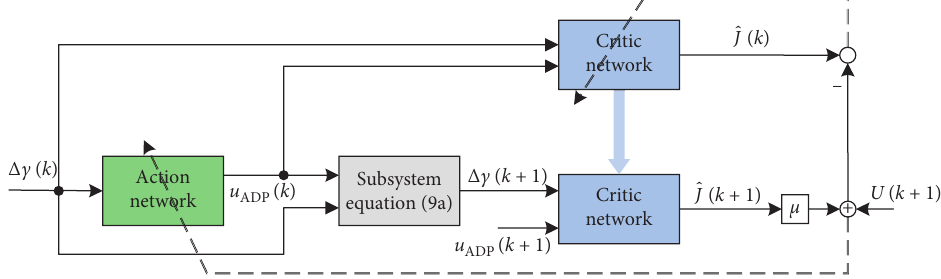
Figure 2: Structure of the ADP controller.